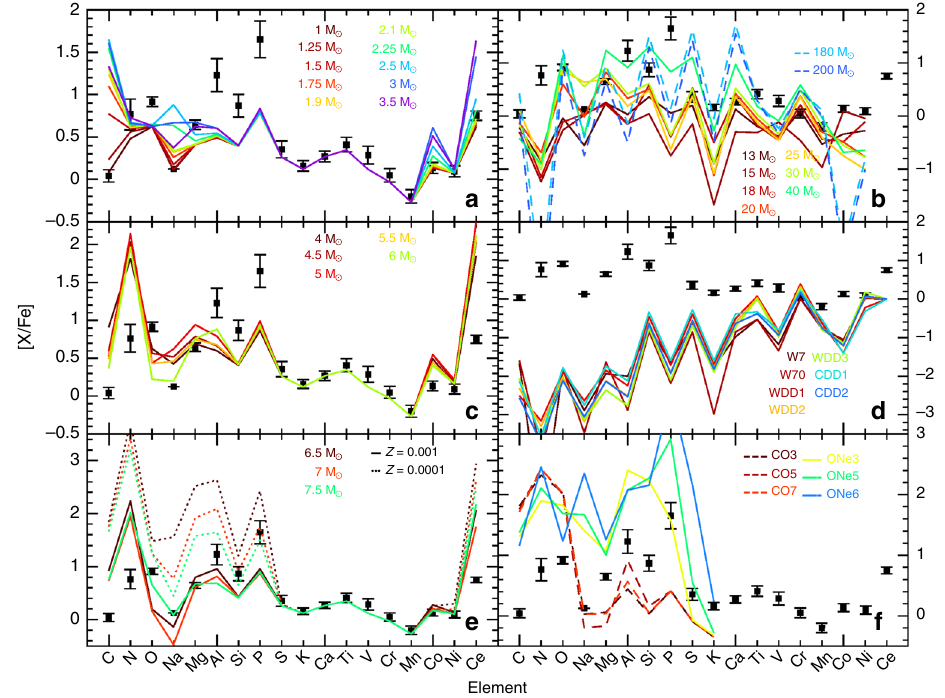
Fig. 6 P-rich stars versus nucleosynthesis predictions. Median chemical abundance pattern of the P-rich stars (black squares) against the several model prediction patterns (colored lines), where [X/Fe] = log10( n (X)/n(Fe))-log10( n (X)/n(Fe)) ⊙ . Error bars show the star-to-star abundance rms scatter. a The low-mass AGB subpanel shows the yields 20 for a metallicity of Z = 0.004 (Fe/H] ~ − 0.7) and various initial masses [1.0 – 3.0]M ⊙ in a rainbow fashion (steps of 0.5 M ⊙ ), the redder being the lower masses. b In the core collapse supernova (SNII) subpanel, we show standard models (i.e. without any speci fi c effect like rotation or O-C mergers) where the mass range is [13 – 40]M ⊙ and metallicity such that Z = 0.001 ([Fe/H] ~ − 1.3) 22 . In the same subpanel, the pair-instability supernovae (PISN) yields 62 are represented by dashed lines for masses of 180 and 200 M ⊙ . c The initial masses of the intermediate-mass AGB predictions 20 (intM-AGB) range from 3.5 to 6 M ⊙ with Z = 0.004 (or [Fe/H]~ − 0.7). d The SN Type Ia (SNIa) yields 63 cover all values in central densities (1.37 × 10 9 – 2.12 × 10 9 g cm − 3 ) and de fl agration speeds (1.5% – 5% of sound speed) provided by the authors. e Theoretical predictions for super- AGB stars 64 (S-AGB) at two metallicities ( Z = 0.001, 0.0001 or [Fe/H] ~ − 1.3, − 2.3; continuous and dotted lines, respectively) and three initial masses (6.5, 7.5 and 8.0 M ⊙ ) are displayed. f Finally, we display the only solar metallicity ( Z = 0.014 or [Fe/H] ~0.0) novae yields available in the literature 65 with CO core WDs (dashed lines) and ONe WDs (continuous lines) with the same mass range of [0.85 – 1.15]M ⊙